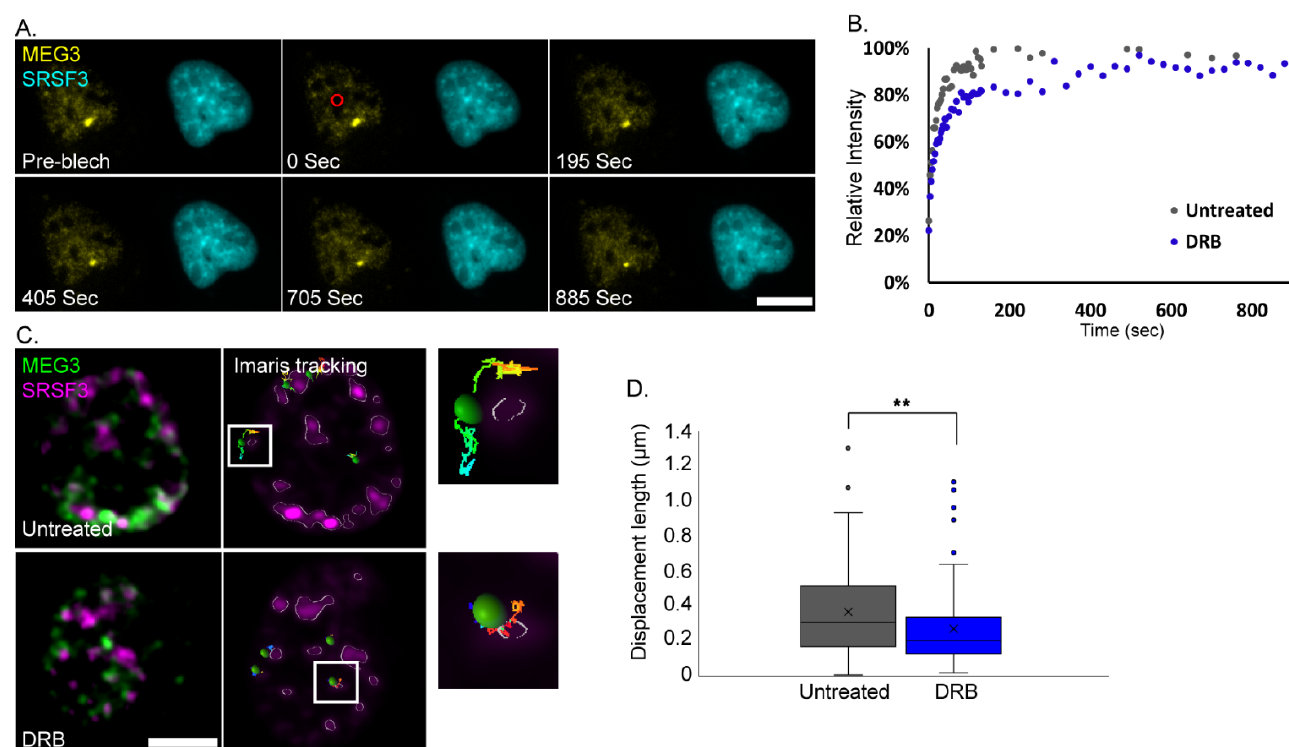
Figure 7. MEG3 is highly associated with nuclear speckles during transcription inhibition. ( A ) Frames from a FRAP experiment showing MEG3 YFP-MS2-CP signal (yellow) and Cer-SRSF3 (cyan) in the same cell. Photobleached area — red circle. ( B ) FRAP recovery curves of MEG3 at nuclear speckles (#untreated cells = 27, #DRB treated cells = 21, * p < 0.05 in the middle phase of the recovery curve) in untreated (grey) cells and DRB-treated (blue) cells. DRB-treated cells were imaged during the second hour of the treatment. Statistical analysis was performed using three-parameter asymptotic regression as detailed in the Methods. ( C ) Tracking MEG3 YFP-MS2-CP (green) in relation to the nuclear speckle marker Cer-SRSF3 (magenta). Unprocessed image (left) and Imaris rendering (right) of untreated (top) and DRB treated (bottom) cells. Enlargements of frames from the boxed areas appear in the images. Bars = 10 μ m. ( D ) Plot demonstrating the displacement length of MEG3 movements within a 0.25 μ m radius of nuclear speckles (NS) under untreated conditions (#cells = 27, #RNA = 108) and DRB treatment (#cells = 25, #RNA=105) ( t -test, ** p < 0.005). The "x" in the boxplots represents the mean displacement length of each treatment.